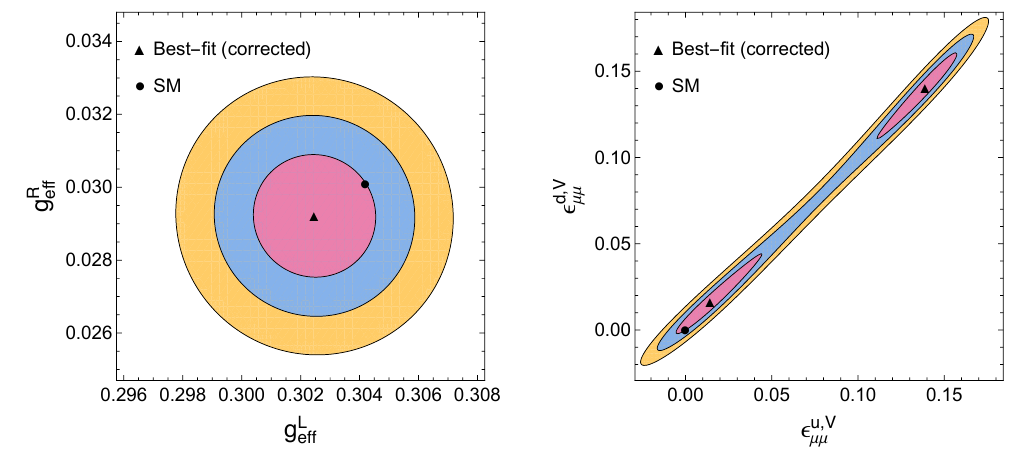
Figure 3 . Allowed regions obtained from the NuTeV measurement. Contours correspond to 1 (cid:27) , 2 (cid:27) and 3 (cid:27) for 2 degrees of freedom. The triangle indicates the best-(cid:12)t points, which are completely degenerate. The SM (indicated by a dot) is allowed at 1 (cid:27) . The left panel shows allowed regions (cid:24) in the plane of the couplings g L and g R . The right panel shows the region obtained for the two e(cid:11) e(cid:11) vector NSI parameters (cid:15) u;V and (cid:15) d;V , after setting all other NSI parameters set to zero. (cid:22)(cid:22) (cid:22)(cid:22)